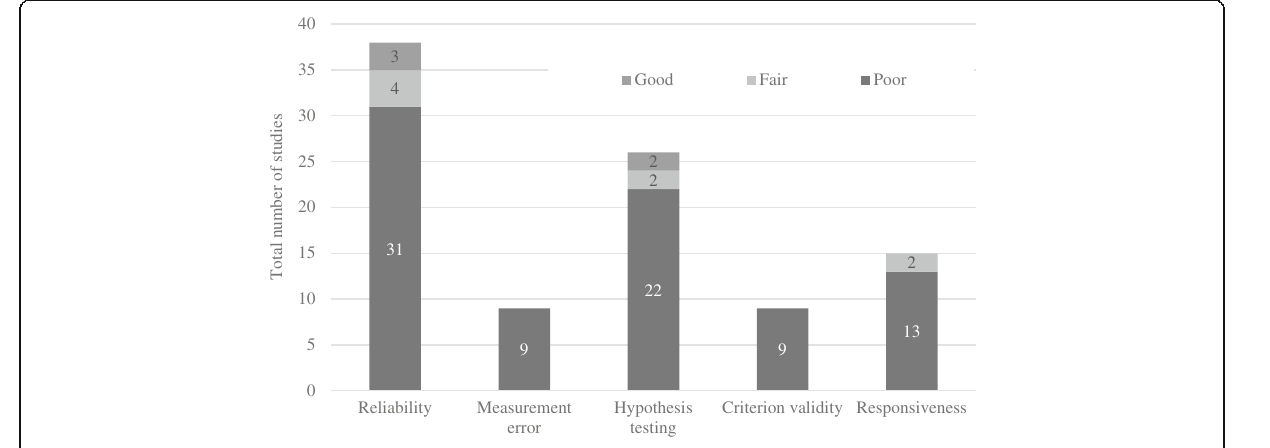
Fig. 2 Rating distribution of included studies for methodological